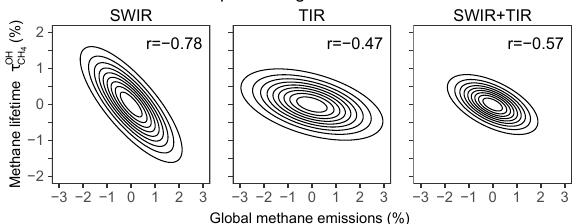
Figure 7. Joint distribution of relative uncertainties in τ OH tal methane emissions as given by the posterior error covariance ma- trices for different satellite observing systems. Contours represent confidence ellipses from probability 0.1 (innermost) to 0.9 (outer- most) at an interval of 0.1. The correlation coefficients ( r ) between errors in τ OH and total methane emissions are inset. CH 4